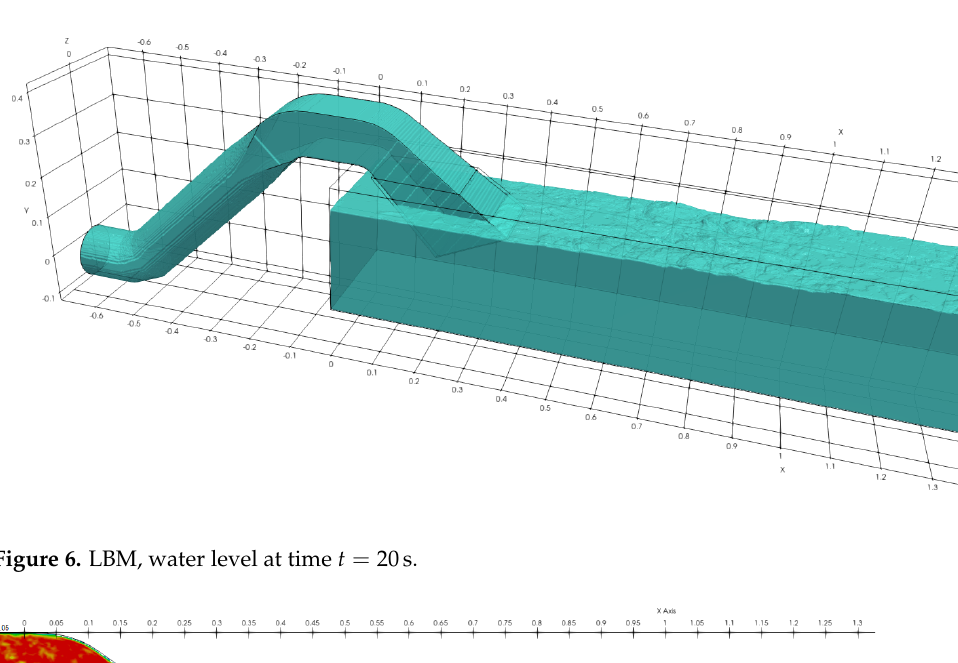
(cid:113) + u 2 u 2 x y